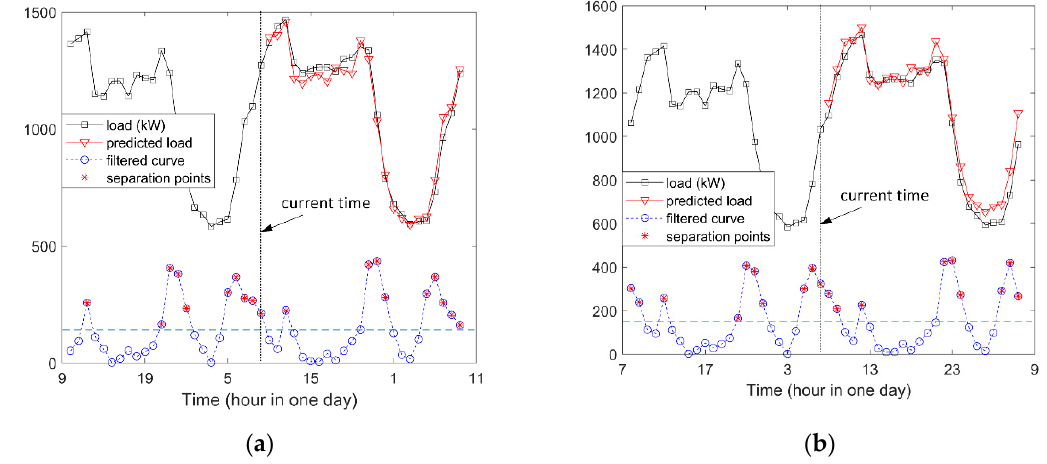
Figure 8. Illustration of observed and predicted load curves in case 6, at time 9 am ( a ) and 7 am ( b ).